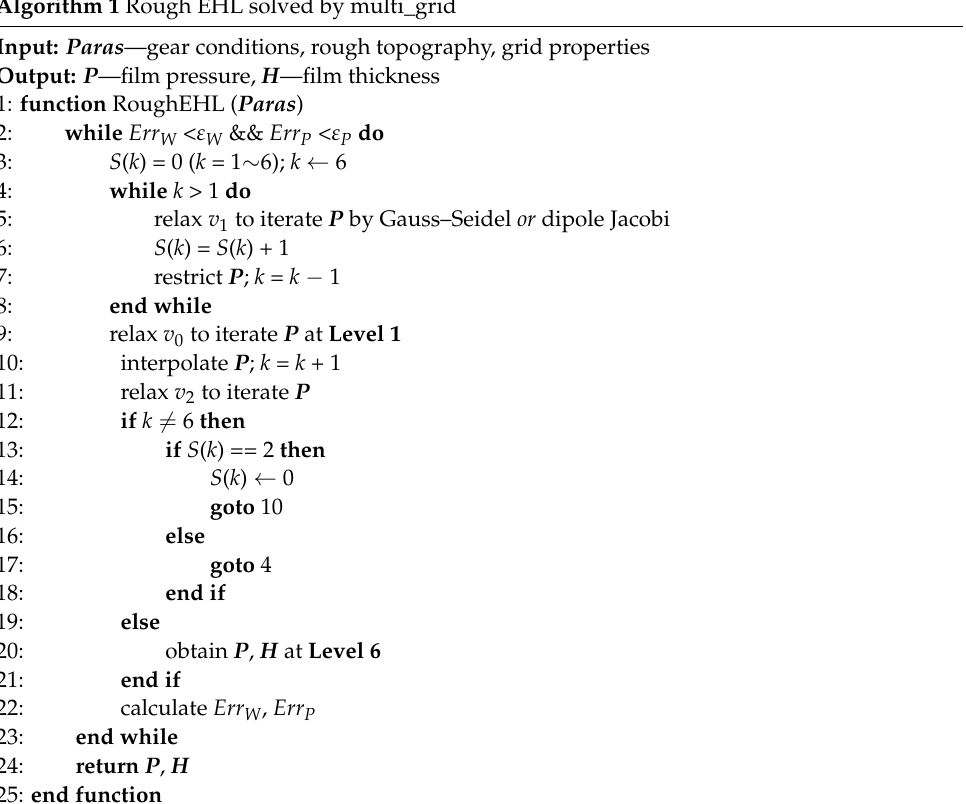
Algorithm 1 Rough EHL solved by multi_grid